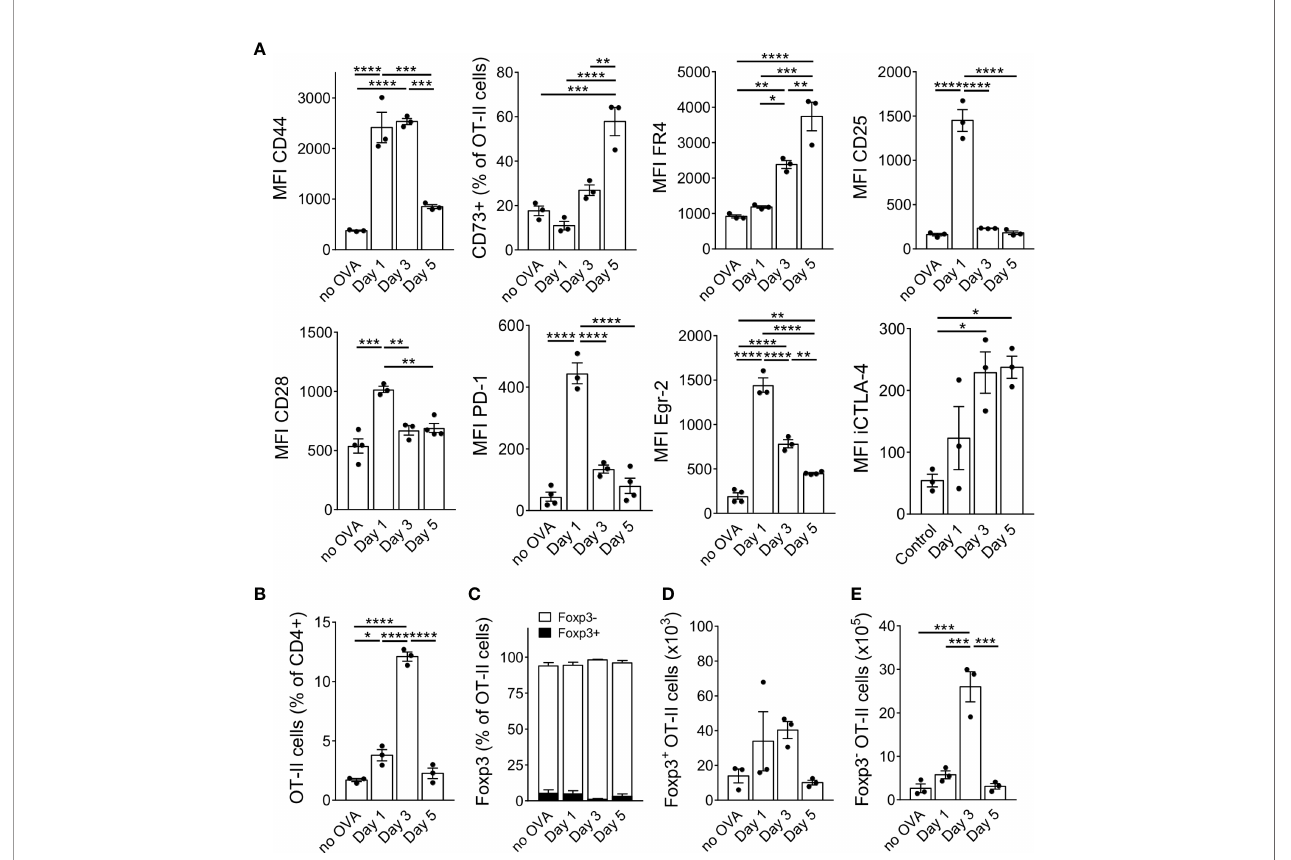
FIGURE 2 | Anergy markers show different kinetics during anergy induction. (A) Expression of anergy markers was analysed in adoptively transferred OT-II cells at different time points after a single OVA injection and is shown as MFI when all cells up-regulated the marker in a uniform manner or as frequency when the population split into positive and negative cells for the marker staining (CD73). (B) Frequency of OT-II cells at indicated time points. (C) Frequency of Foxp3 + and Foxp3 - cells within the OT-II population at indicated time points. (D) Absolute numbers of Foxp3 + and (E) of Foxp3 - cells at indicated time points after OVA protein injections. Data is shown as mean ± SEM. Dots represent individual mice. *p < 0.05, **p < 0.01, ***p < 0.001, ****p < 0.0001, one-way ANOVA with Tukey